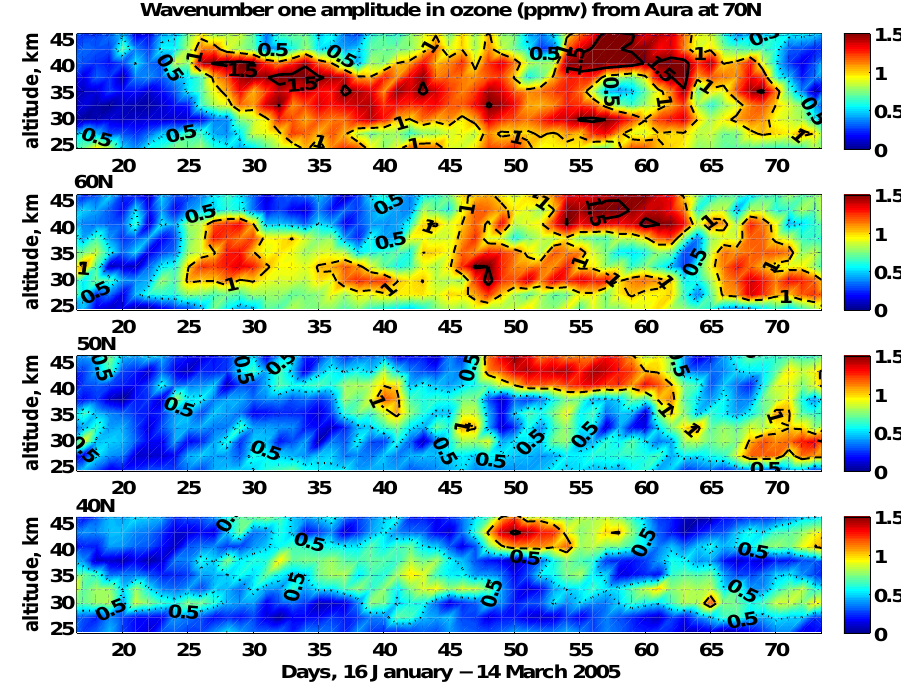
Fig. 14. Wavenumber one amplitude in ozone (ppmv) from Aura MLS data at 70 ◦ N, 60 ◦ N, 50 ◦ N and 40 ◦ N.